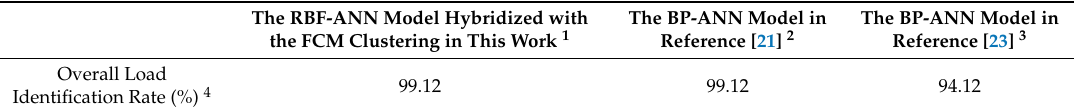
Table 6. Load identification rates obtained, as a comparative study, in this work.